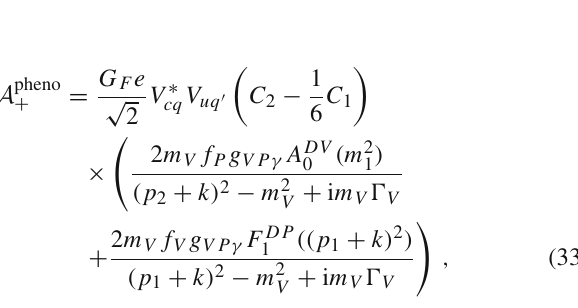
Fig. 8 As in Fig. 7 but for HH χ